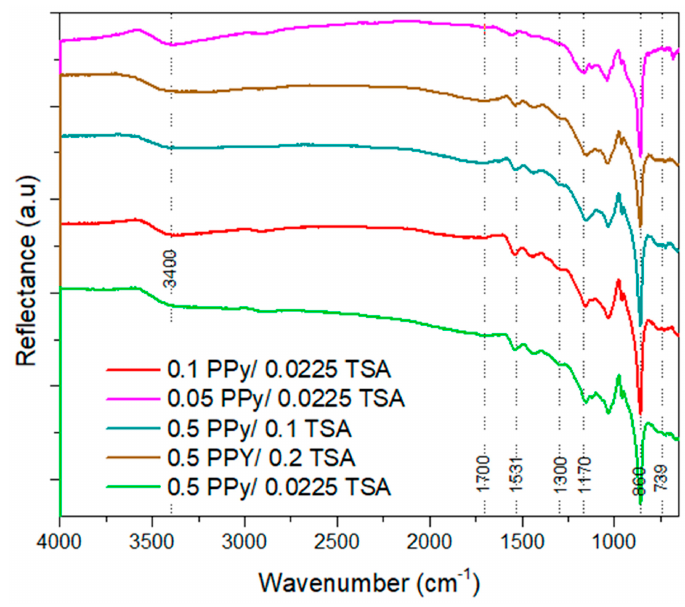
Figure 11. FTIR spectra of PPy doped with pTSA. Table 4. Characteristic FTIR peaks and corresponding functional groups.